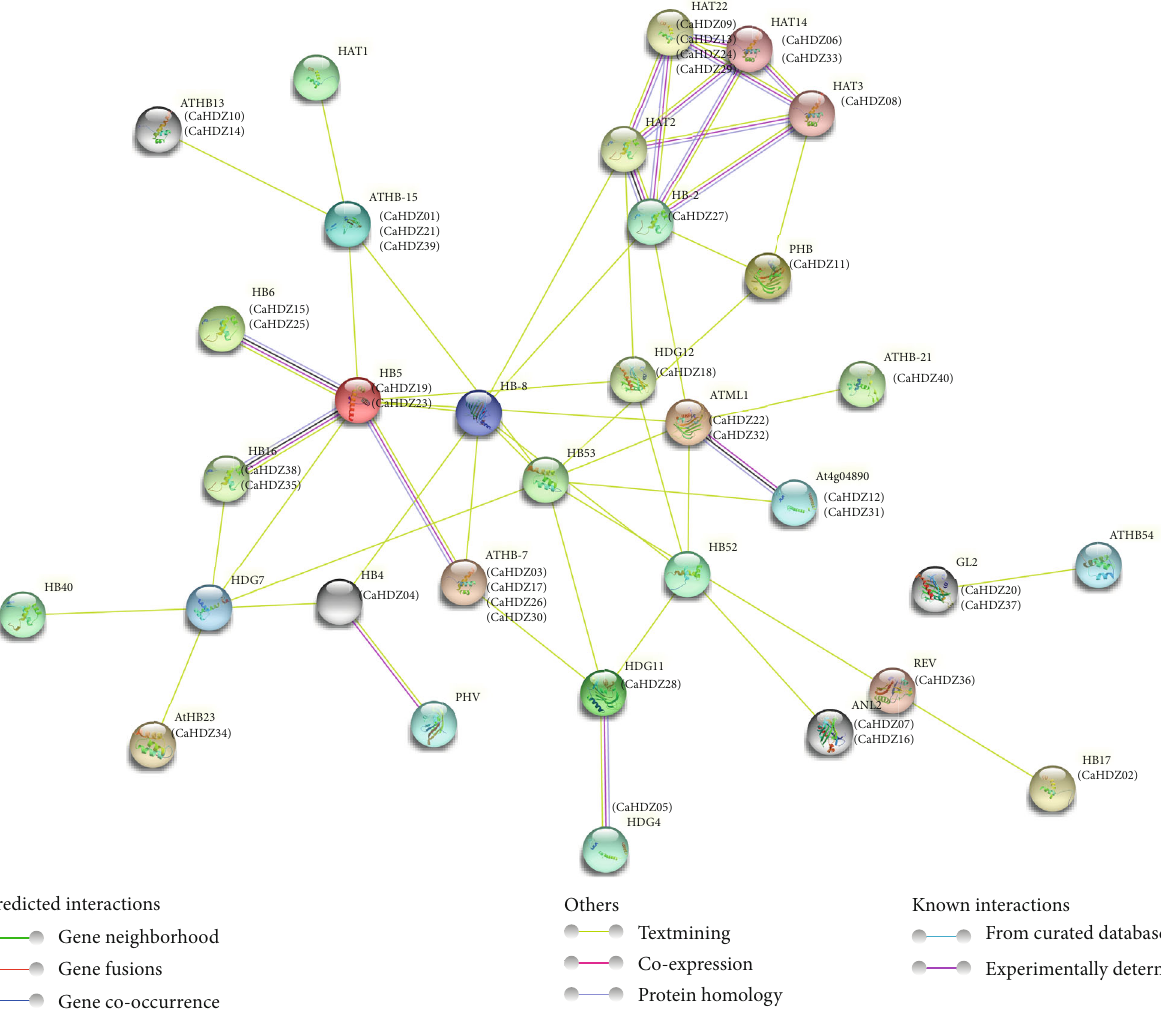
Figure 4: Predicted protein-protein interaction network of CaHD-ZIP proteins. The colors of the line indicate di ff erent data